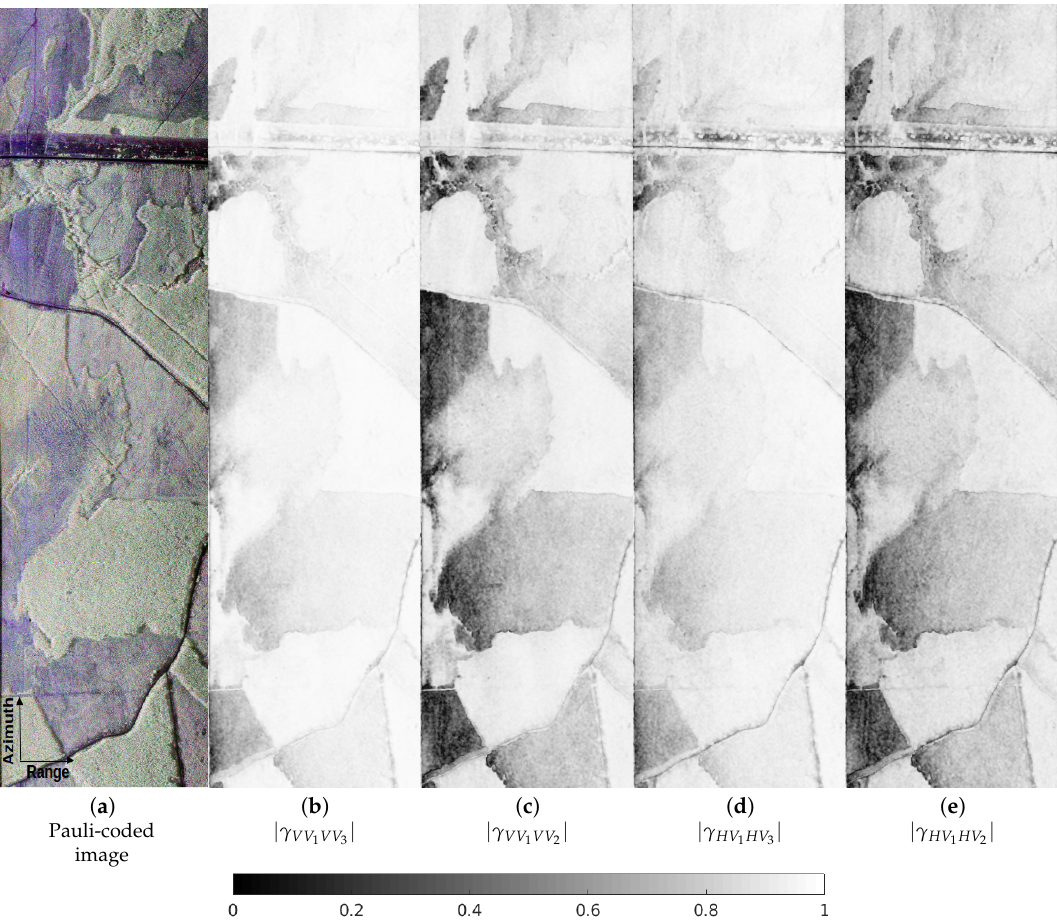
Figure 5. InSAR coherences over the test